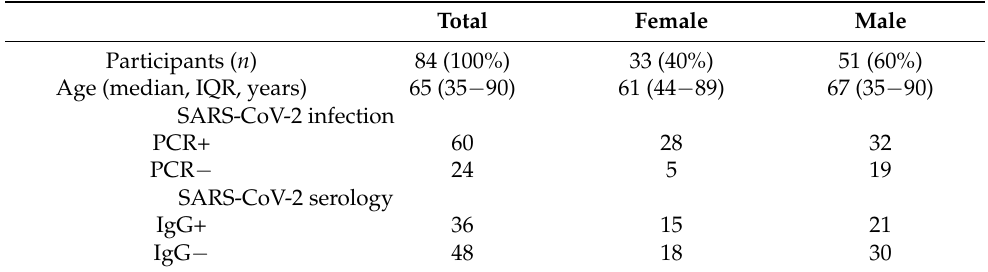
Table 1. Baseline characteristics of patients with SARS-CoV-2 infection. Values are numbers (percent- ages) or median (interquartile range).